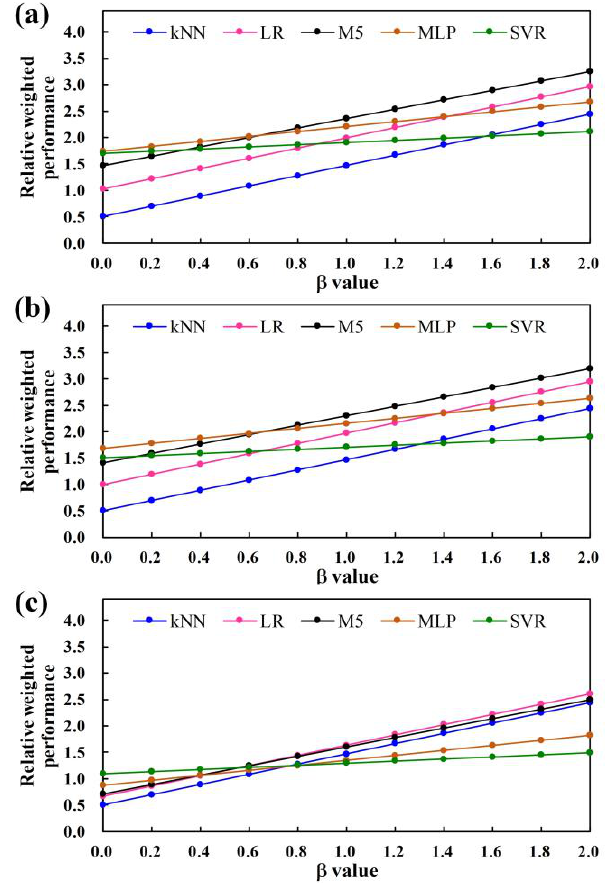
Figure 13. Relative weighted performance of various algorithms for lead time at: ( a ) 1 h, ( b ) 3 h, and ( c ) 6 h.